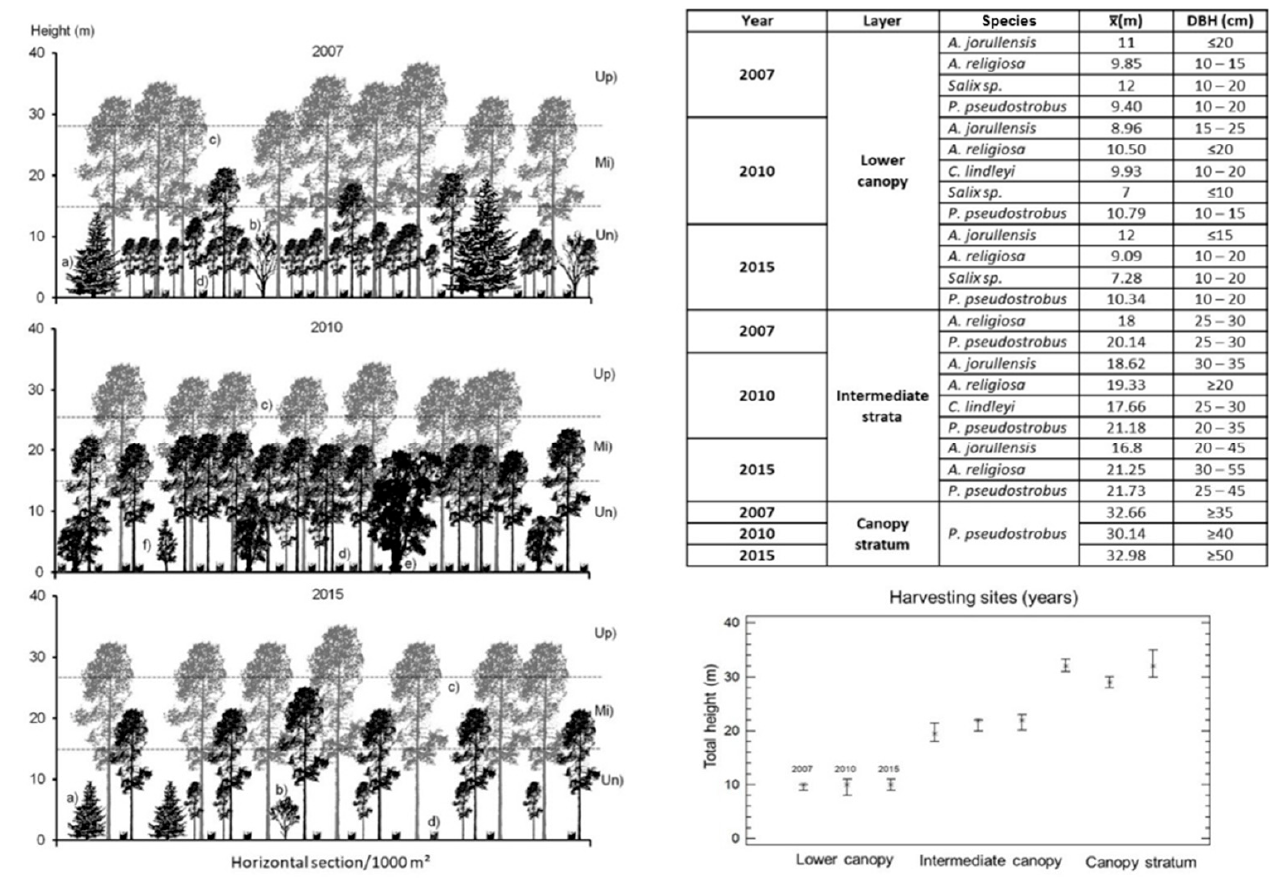
Figure 5. Vertical structure following harvesting in three different years; (a) Abies religiosa , (b) Salix sp., (c) Pinus pseudostrobus , (d) stump, (e) Alnus jorullensis , (f) Cupressus lindleyi . Strata-Un: lower canopy; Mi: intermediate canopy, Up: canopy stratum; mean height and DBH by species, year and stratum; median height by year and stratum.